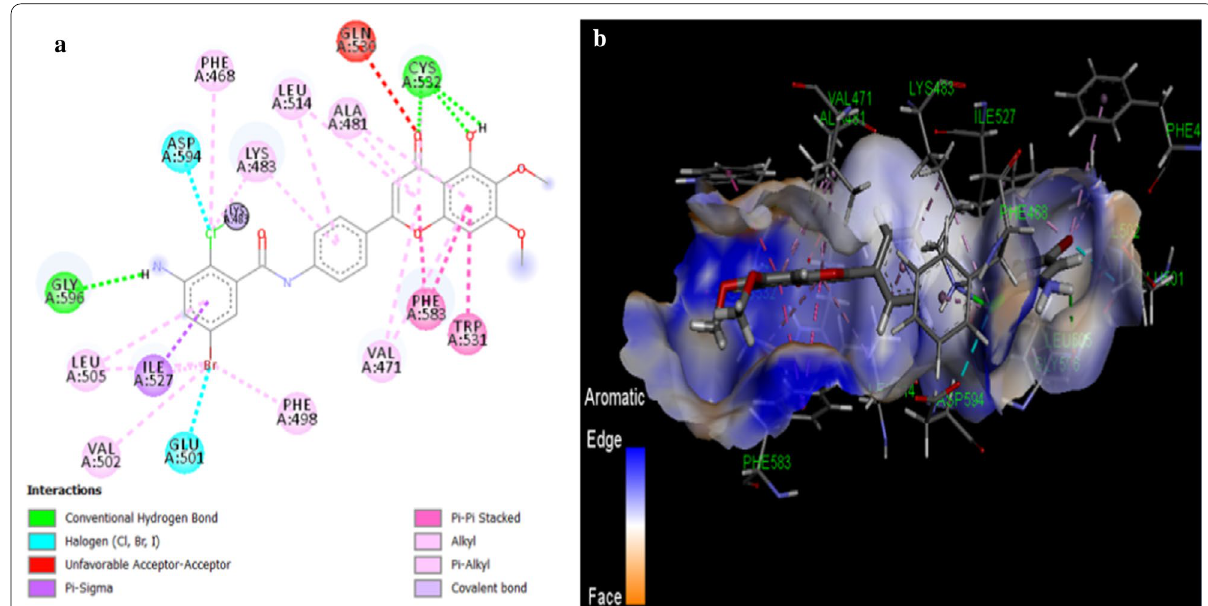
Fig. 3 a 2D diagram for the interaction of compound N1 with V600E-BRAF, b 3D view of the compound N1 in the binding site of V600E-BRAF